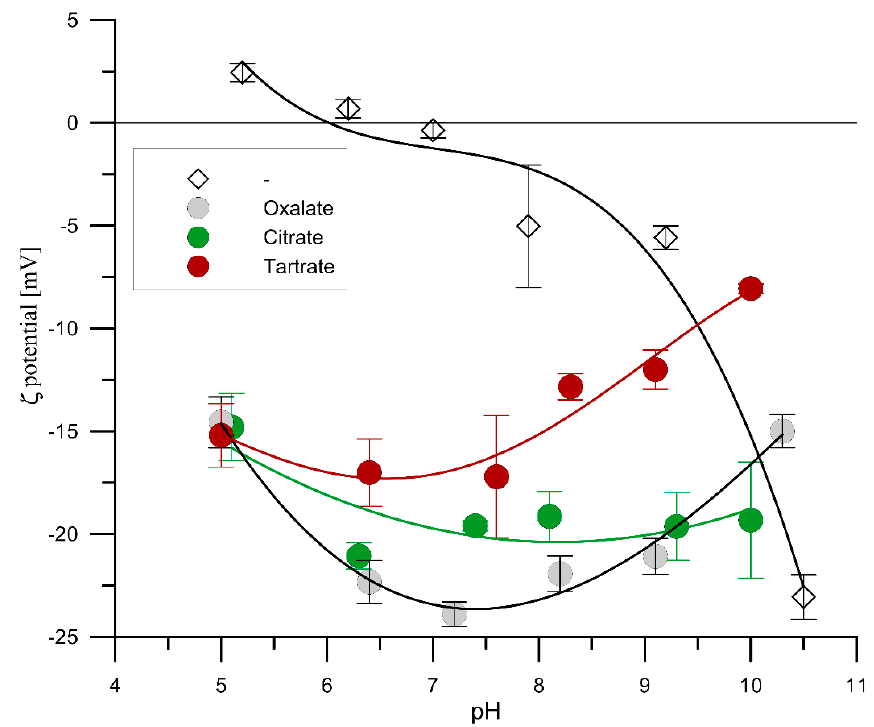
Figure 5. Zeta potential as a function of pH in 0.001 mol/dm 3 (open points) and 0.001 mol/dm 3 oxalate ions (grey closed circle), citrate (green closed circle) and tartrate (wine-colored closed circle).